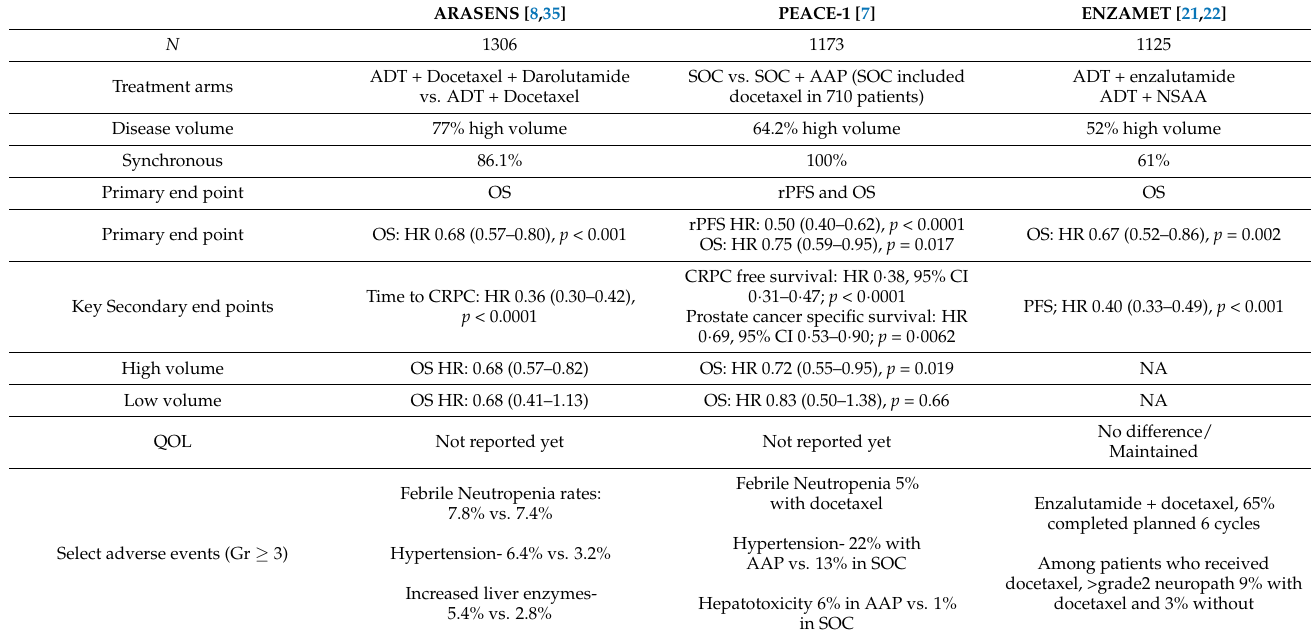
Table 2. Summary of trials evaluating triplet therapy trials in